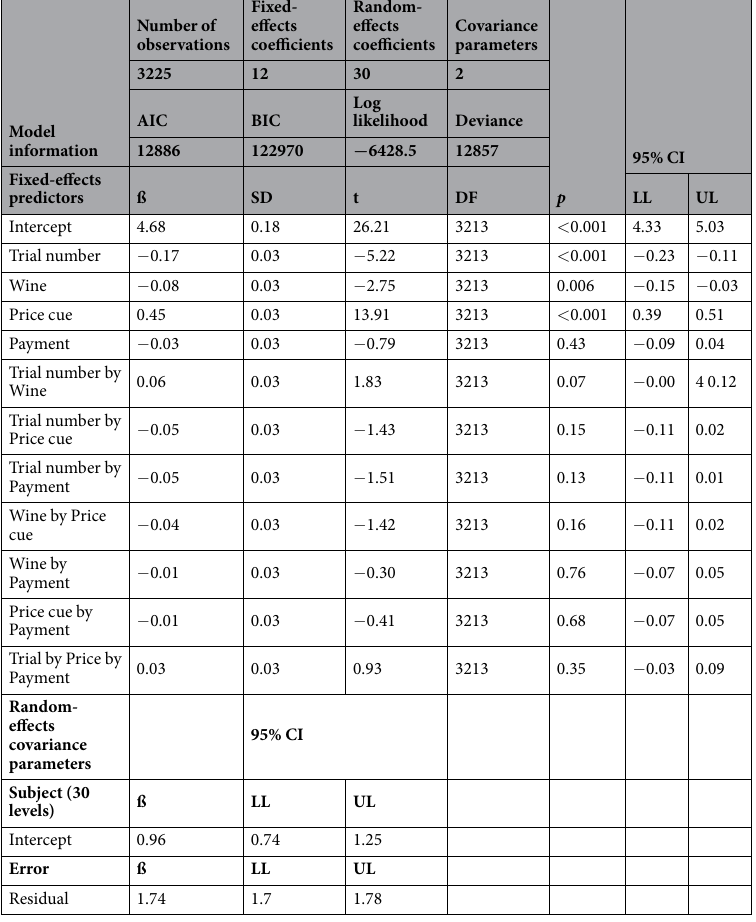
Table 1. Linear mixed-effects model for experienced pleasantness ratings during fMRI